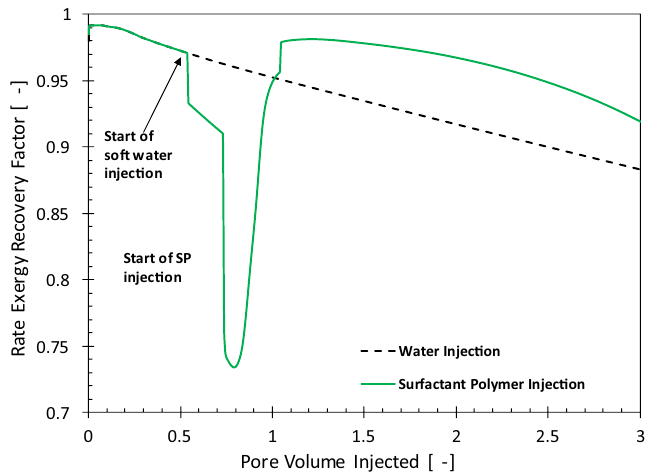
Figure 10. History of the rate exergy recovery factor ( Ex RF ) for surfactant-polymer (solid line) and water- injection (dashed line) cases.